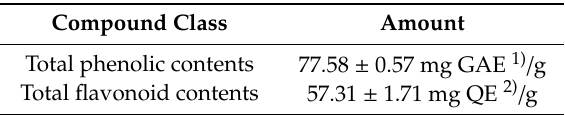
Table 1. Quantification of antioxidant components in LPE.